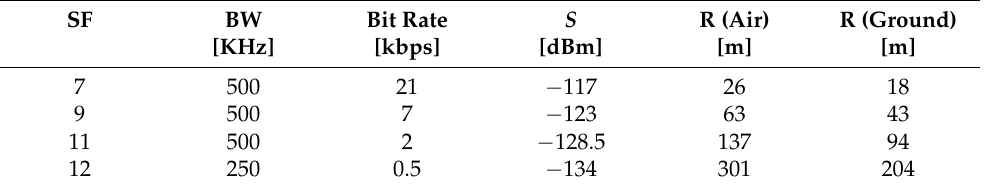
Table 2. Predicted ranges based on the developed path loss model and simulated antenna gain. SF BW Bit Rate S R (Air) R (Ground) [KHz] [kbps] [dBm] [m] [m] 500 −